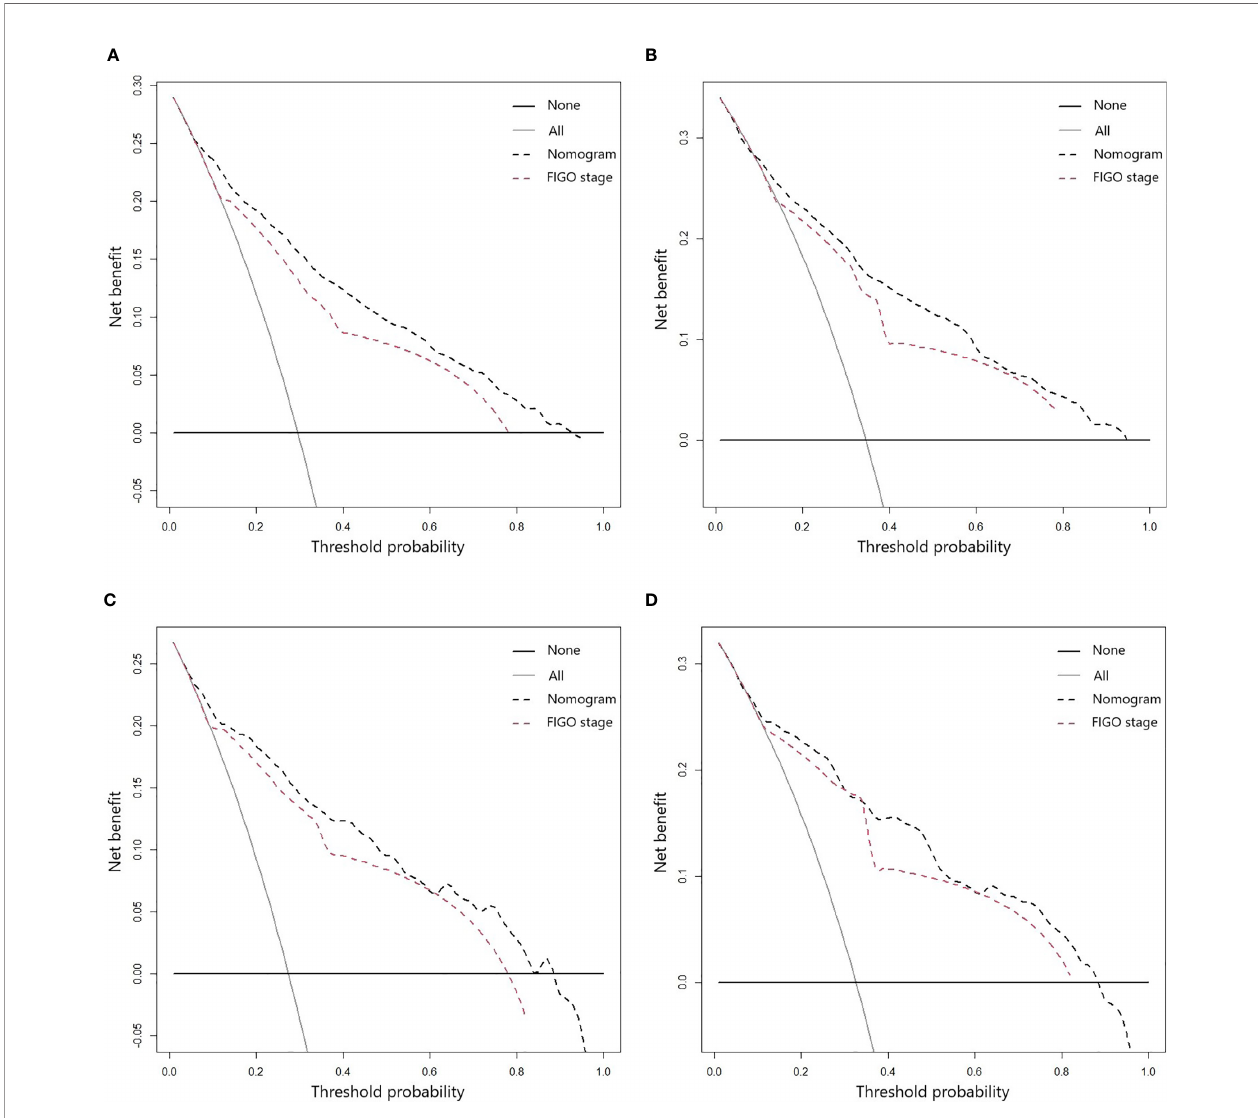
FIGURE 4 | DCA curves for 3- (A) and 5-year (B) CSS of ASCC patients in the training cohort; DCA curves for 3- (C) and 5-year (D) CSS of ASCC patients in the validation